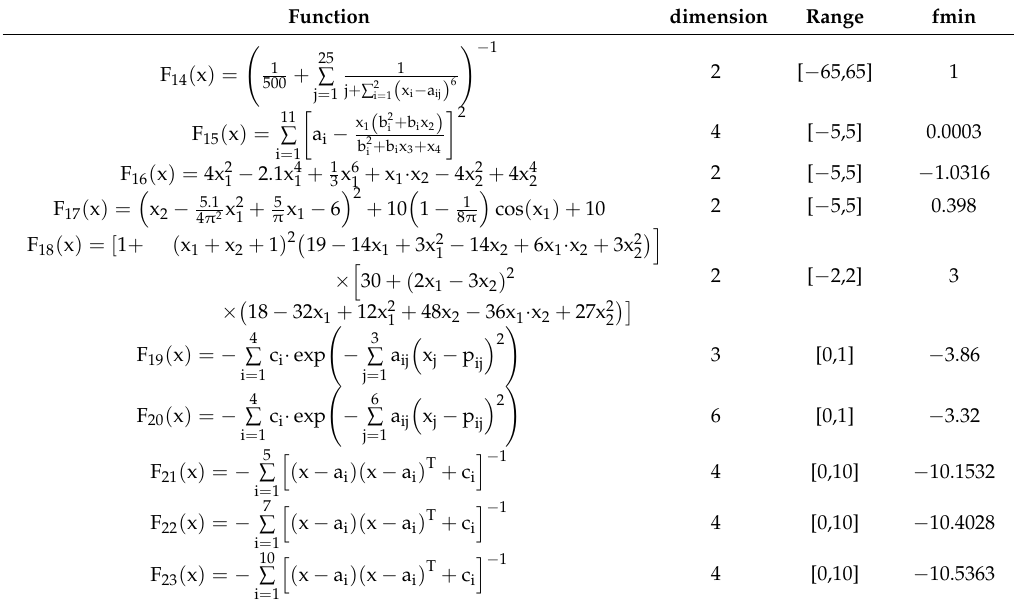
Table 4. Multimodal test functions with fixed dimensions.